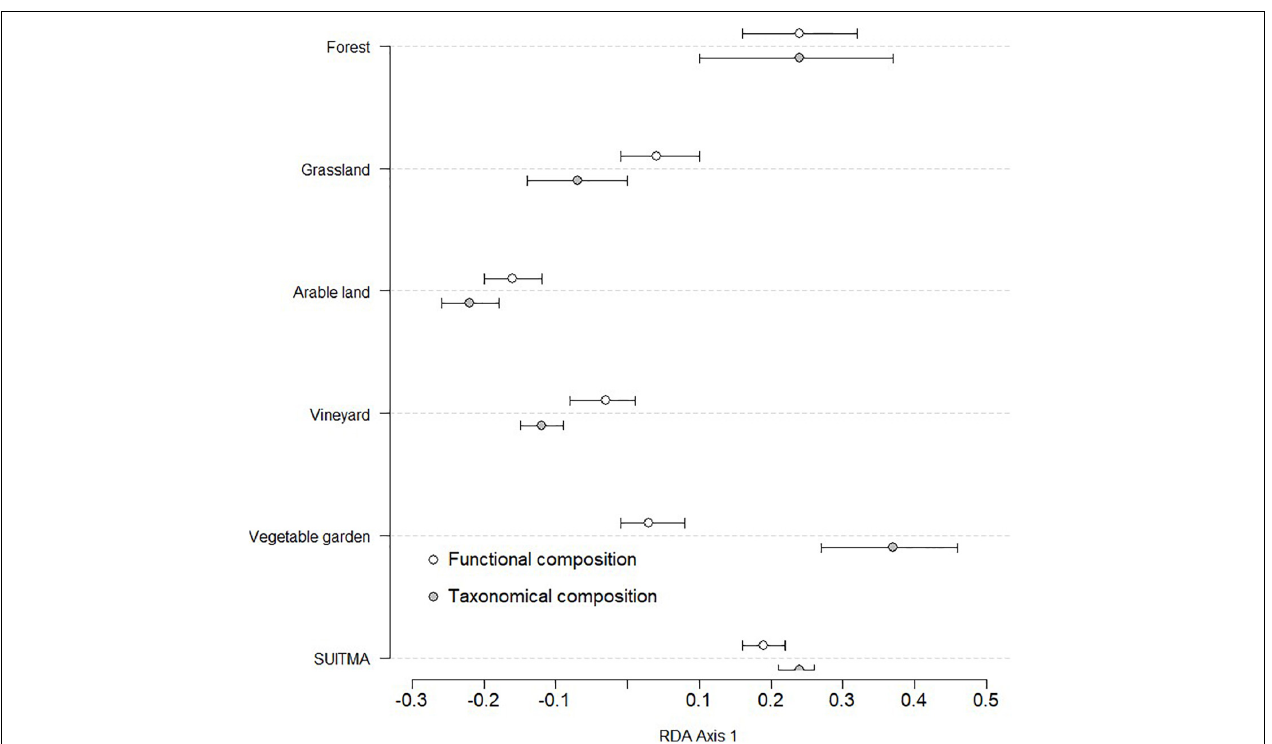
FIGURE 1 | Graphical display of the first axis of Partial Redundancy Analyses (pRDA) on the functional (13% explained) and taxonomic composition (13% explained) of collembolan community. Functional composition corresponds to community -weighted means (CWM) of 8 functional traits resulting a list of 27 attributes, whereas taxonomic composition corresponds to community assemblage (129 species). Horizontal lines represent the 95%